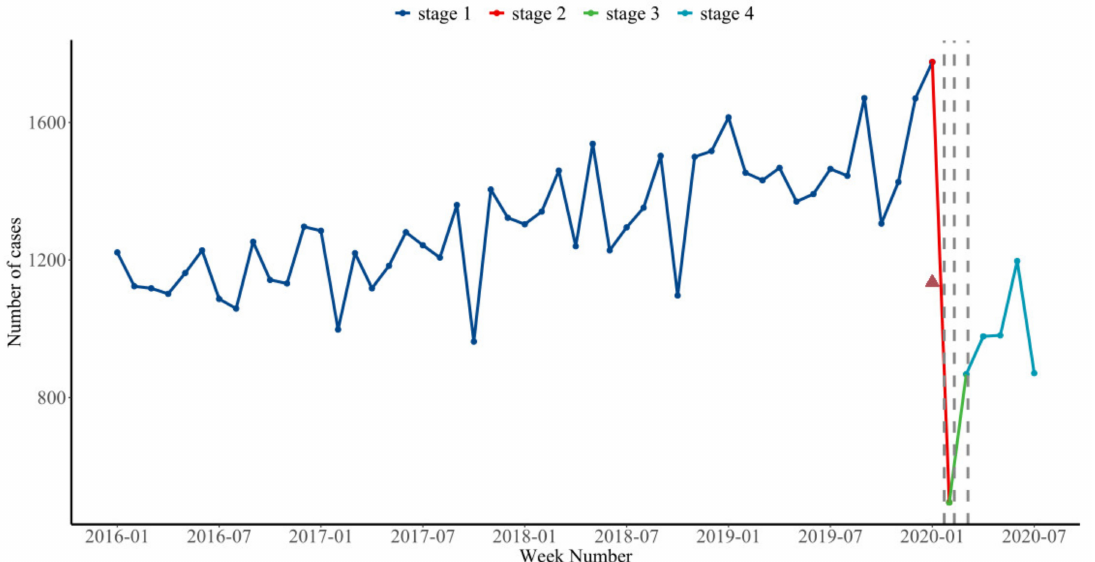
Figure 1. Interrupted time-series of inpatients with mental health between January 2016 and July 2020 in Shanghai. Legend: The dark blue line = pre-pandemic period, stage1 (1 January 2016 to 21 January 2020); the red line = peak-pandemic period, stage2 (22 January 2020 to 9 February 2020); the green line = the post-peak pandemic period, stage3(10 February 2020 to 1 March 2020); the light blue line = the post-pandemic period, stage4 (2 March 2020 to 31 July 2020). The red triangle is the day of Chinese New Year. The dashed vertical line represents policy nodes. Vertical lines represent the changes in prevention and control measures in Shanghai.